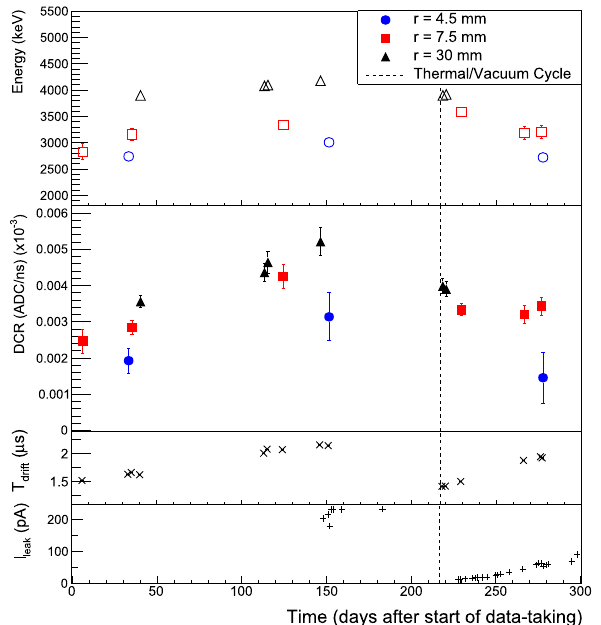
Fig. 17 Stability studies of surface event charge collection conditions. The thermal and vacuum cycle date is indicated by the dashed line. Top: energies of the α peak with the source incident at several positions on the passivated surface, with positive and negative-radii scans combined. Second from top: DCR values of the α peak in the same data sets. The error bars in the energy and DCR plots indicate the 3 σ width of the peak. Second from bottom: the long drift time peak centroid (see fit results in Fig. 18) in each of the data sets displayed in the upper panels. Bottom: the steady-state leakage current in the detector, measured at the test point of the 2002c Mirion preamplifier